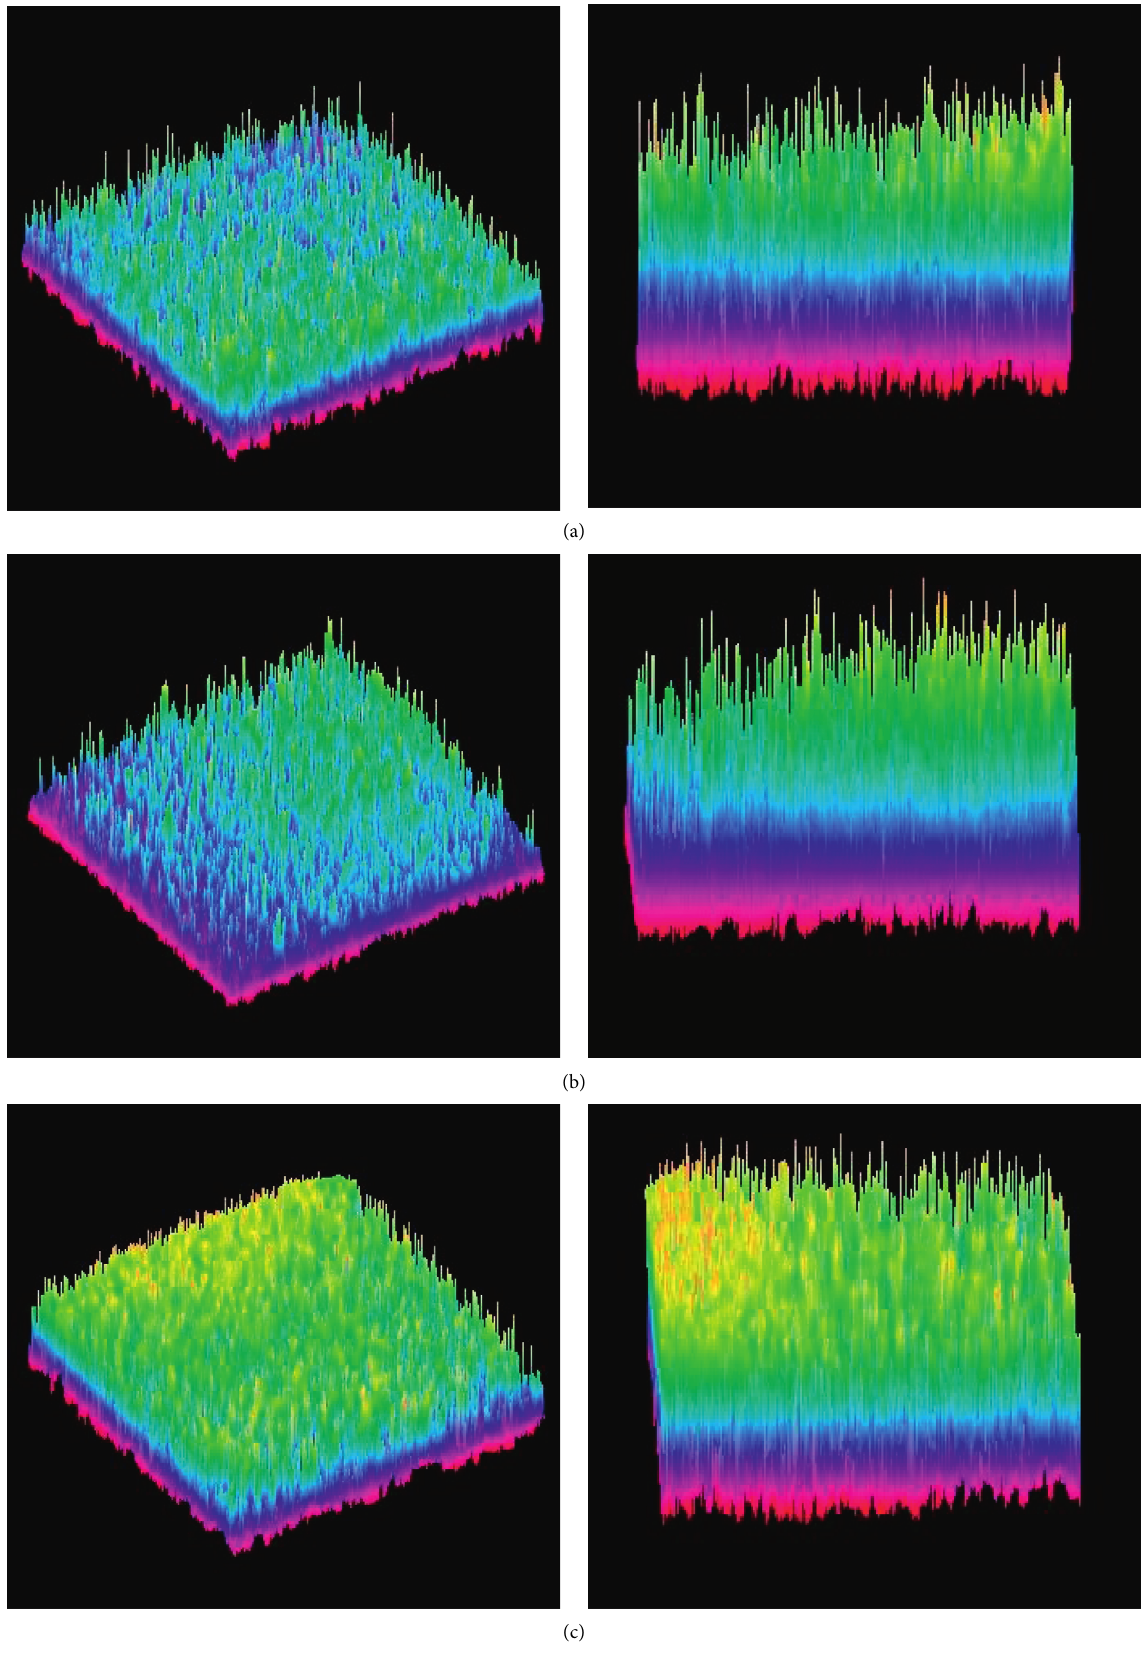
Figure 19: The 3D structure of the surface of the specimen with different construction process: (a) one asphalt one sand; (b) double asphalt one sand; (c) premix